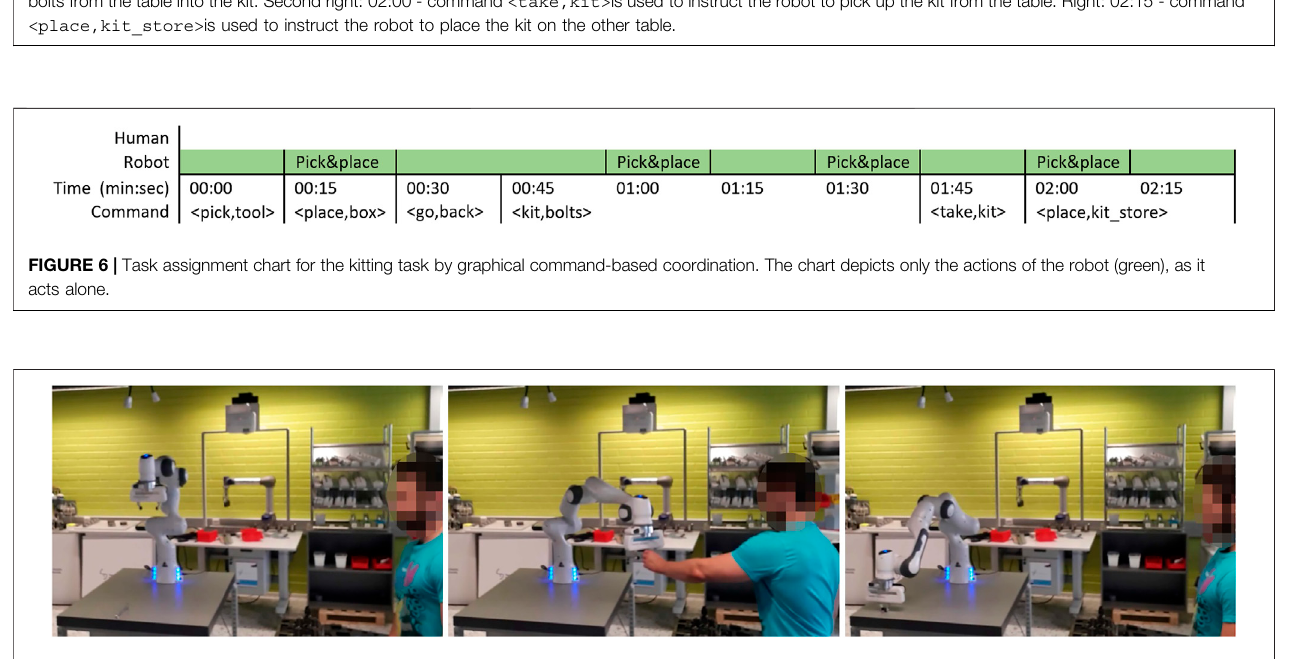
FIGURE7| Differentstagesofthehand-overscenariobyspeechcommand-basedcoordination.Left:00:00-command < give,tool > isspoken,whichinstructs the robot to hand-over the wrench from the table to the person. Middle: 01:30 - commands < come,here > and < take,bolt > are spoken to instruct the robot to receive a bolt from the person. Right: 01:45 - command < give,bolt > is spoken to instruct the robot to pick up and hand-over a bolt from the table to the person.